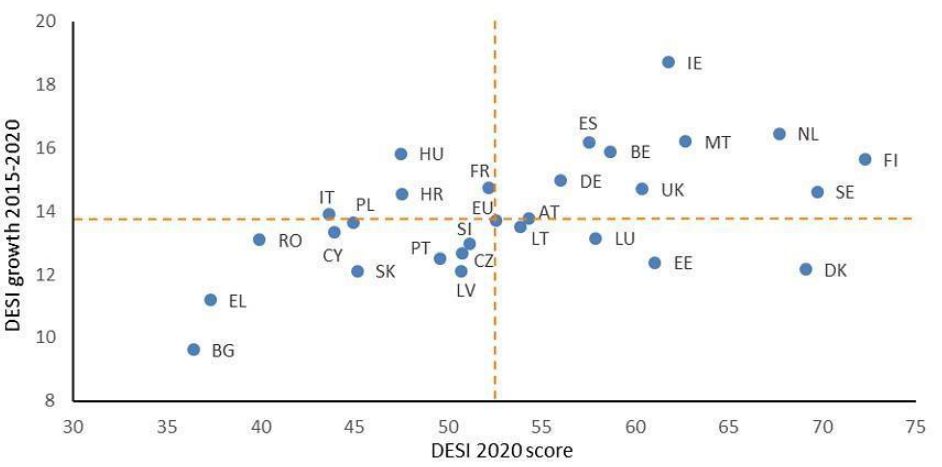
Figure 1. The Digital Economy and Society Index growth among the EU Member States in